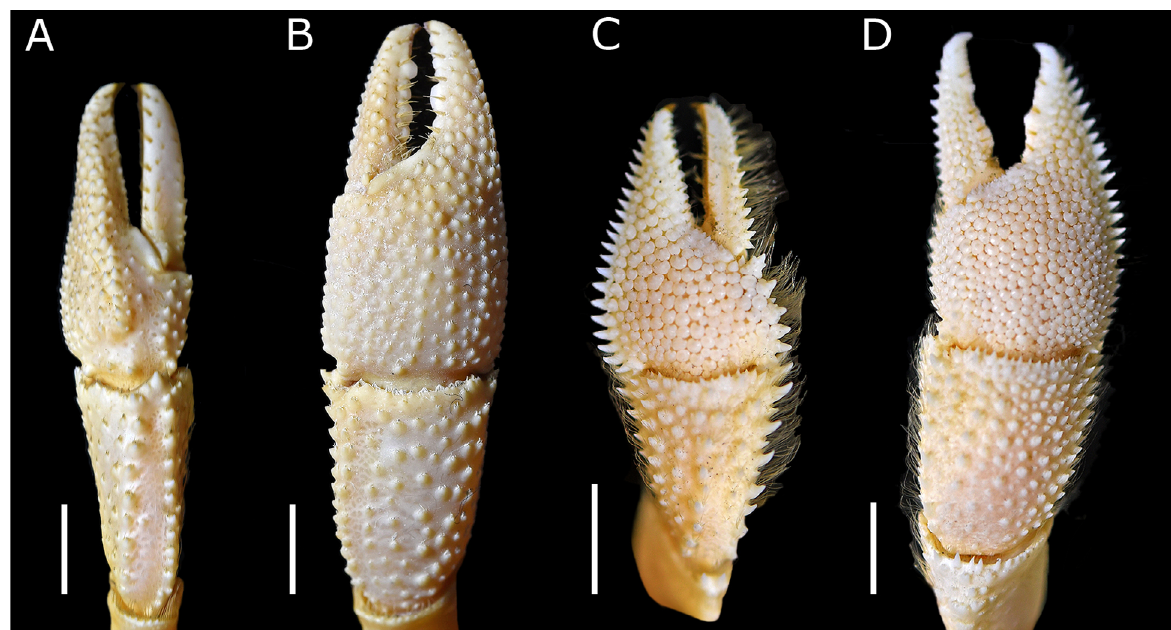
Figure 2. Carpus and chela of chelipeds, dorsal view. Pagurus politus (Smith, 1882), male lectotype 7.9 mm, USFC Albatross, sta 2823, northwestern Atlantic, Martha’s Vineyard, Massachusetts (USNM 16716): A , left; B , right. Pagurus smithi (Benedict, 1892), male lectotype 7.9 mm, USFC Albatross, sta 2823, northeastern Pacific, southern part of Gulf of California, Mexico (USNM 16716): C , left; D , right. Scales = 1